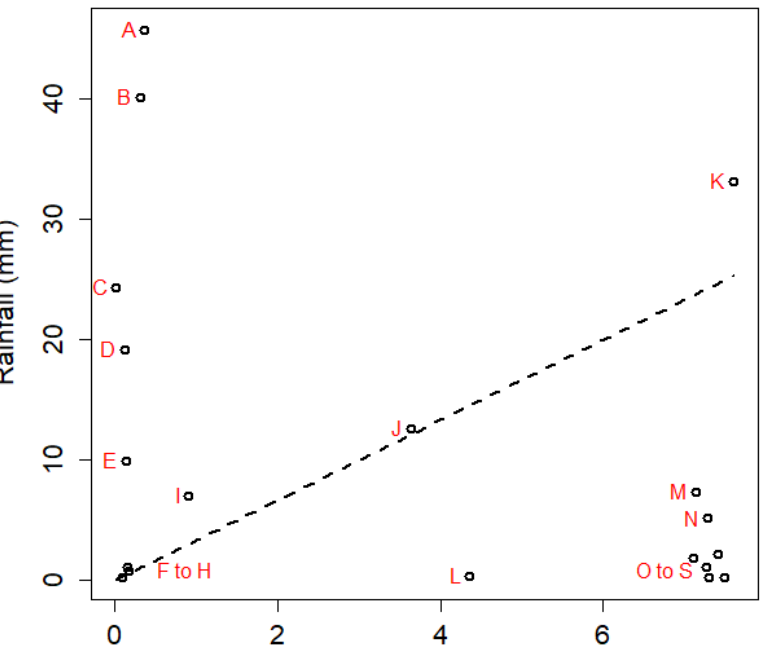
Figure 3. Normalized cistern water level drained before rainfall. Storms ( n = 19) include all events with an antecedent dry-weather period of one–two days when the cistern was already full. Dotted line traces perfect forecasting. Storms A–E represent the smart sensor underanticipating the coming storm; storms L–S denote the smart sensor overestimating the storm; and storms F–K represent accurate predictions.